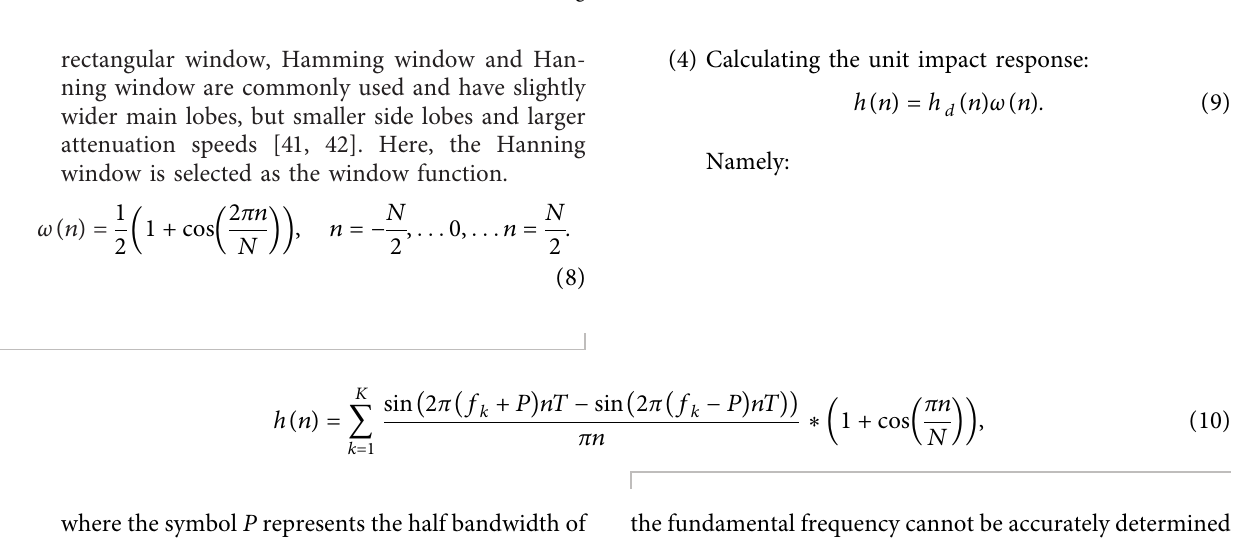
Figure 11: The design idea of multiband